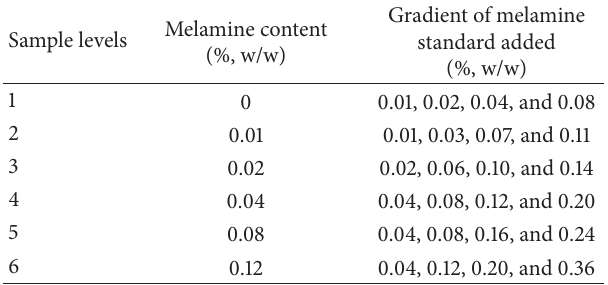
Table 2: Composition of serial samples spiked with different amounts of melamine